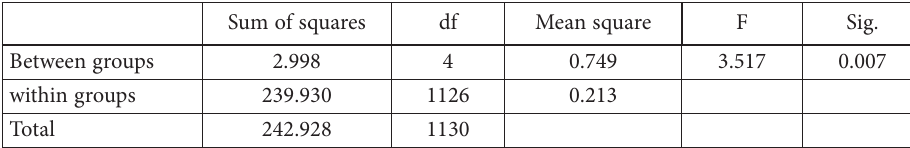
Table 6. Results of one-way analysis of variance test showing the effect of practicing creative thinking on academic achievement (source: created by authors) Sum of squares df Mean square F Sig.